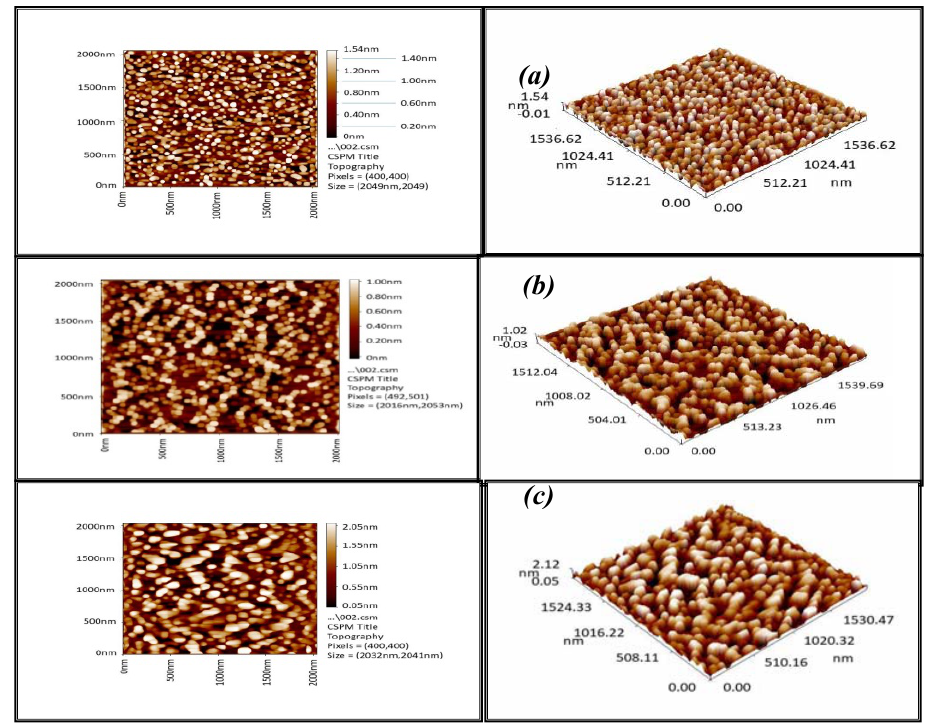
Fig. 4: AFM images of P3HT:PC BM thin films at (a) as-deposited thin film (b)Ta=100 ° C 61 (c) Ta=150 ° C. Table 2: Grain size, Roughness average, and root mean square of as deposited and annealed